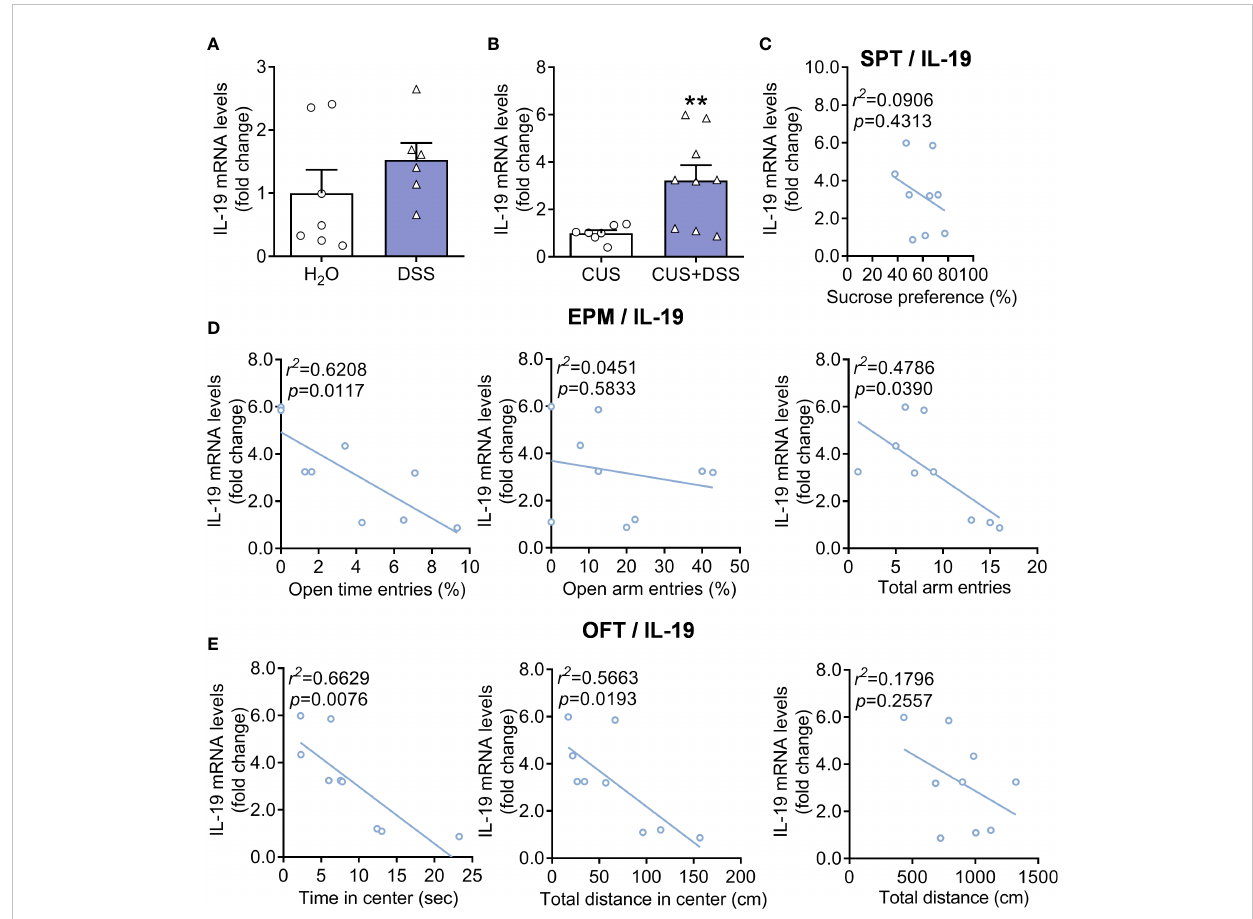
FIGURE 4 Expression levels of IL-19 in DSS or DSS/CUS mice colon. IL-19 mRNA levels in (A) DSS or (B) DSS/CUS mice. H 2 O group: n= 7, DSS group: n=6. CUS group: n=7, CUS + DSS group: n=9. The correlation analysis of (C) SPT, (D) EPM, and (E) OFT with the mRNA levels of IL-19 in the DSS/CUS mice. ** p < 0.01, compared to the control